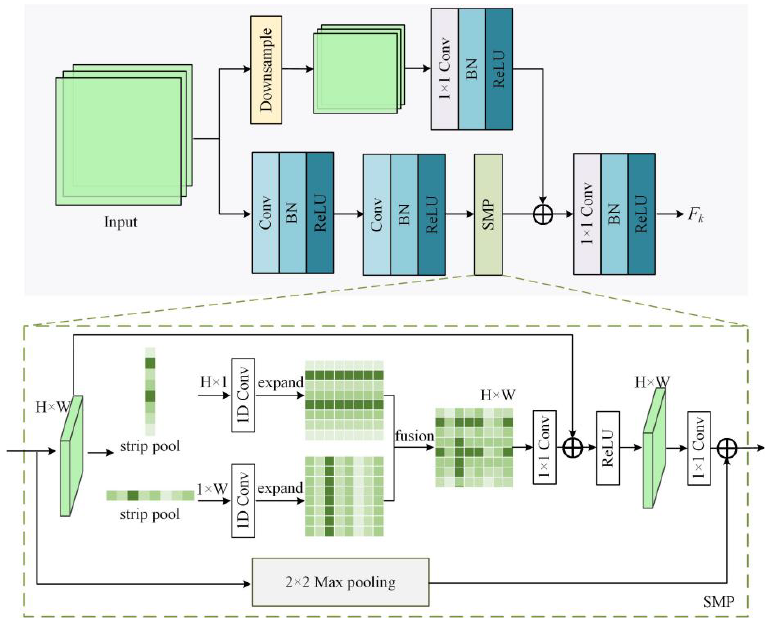
Figure 4. The MICM submodule and SMP architecture.